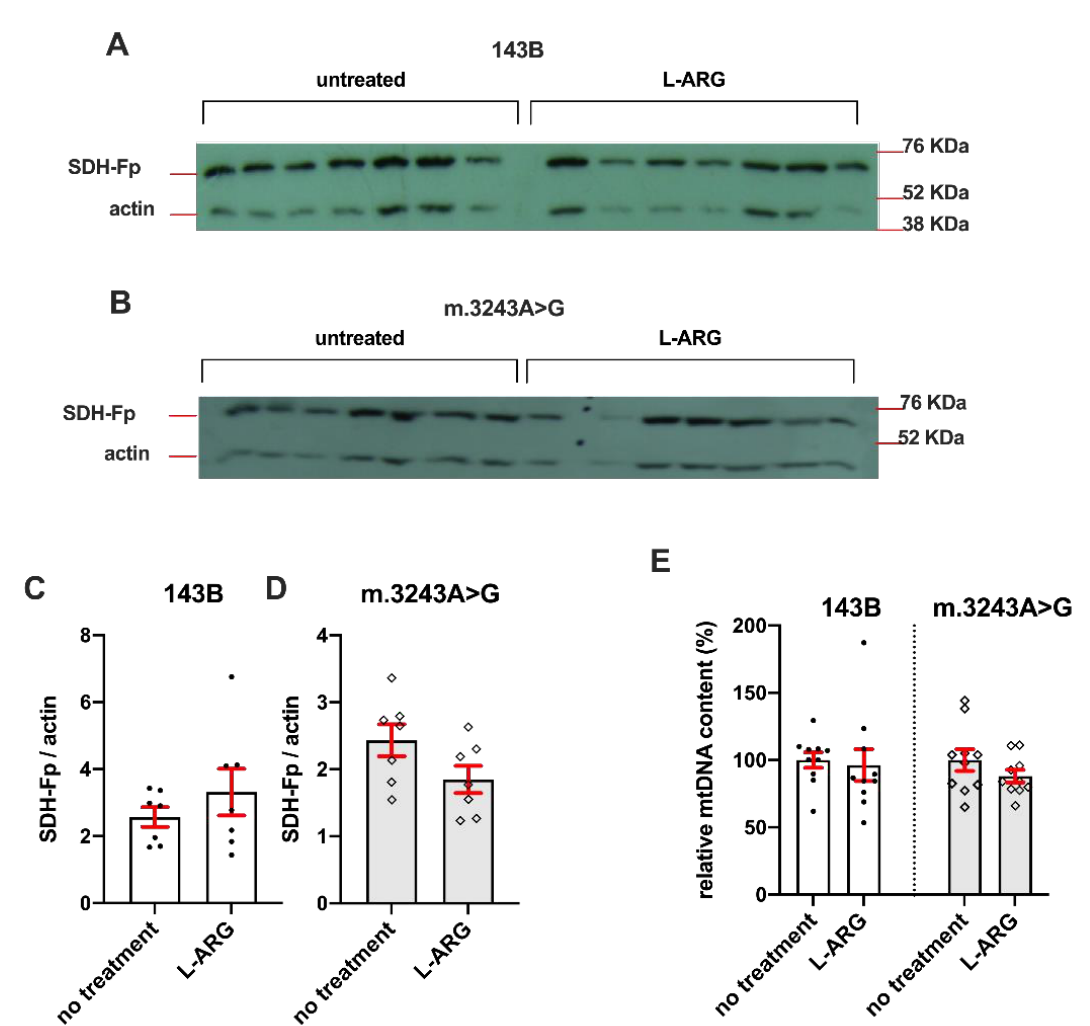
Figure 3. Mitochondrial mass was not altered by L-ARG supplementation. Mitochondrial content was evaluated by Western blotting ( A – D ) and mtDNA quantification ( E ). Fp expression, which is not affected by the m.3243A>G mutation, was detected by Western blotting in 143B ( A ) and m.3243A>G cells ( B ). Actin expression was used for the correction of protein content. Quantification of the bands did not demonstrate any statistical difference between L-ARG and untreated cells ( C , D ). Relative mtDNA content was expressed as the mtDNA/nDNA ratio relative to each experiment’s mean of the untreated group. The graph ( E ) shows no difference between the untreated and L-ARG group in both cells, 143B and m.3243A>G. Results are from two independent experiments ( n = 5 in each group). Statistical analysis was conducted using a two-way ANOVA followed by Tukey’s post hoc